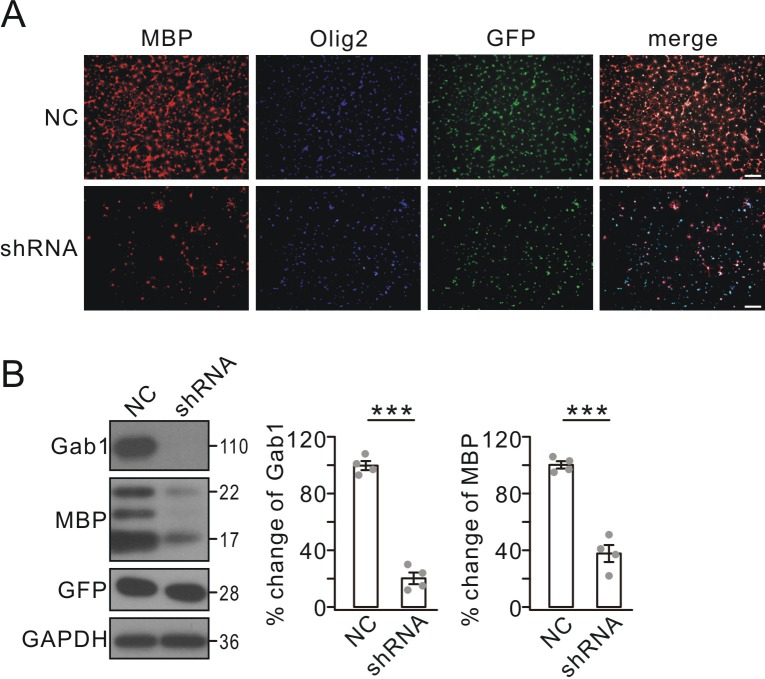
Effects of Gab1 knockdown on OPC differentiation in vitro.(A) OPC cultures were transfected with lentiviral vector-encoding with GFP (NC) or GFP-tagged Gab1 shRNA (shRNA), stimulated with T3 for 3 days, and immunostained with anti-MBP (red) and anti-Olig2 (blue) antibodies. Scale bar, 40 μm. (B) Expressions of Gab1, MBP, GFP, and GAPDH in OPCs treated with NC or shRNA following triiodothyronine treatment. Gab1 and MBP were normalized to corresponding GAPDH and percent changes are summarized. Gab1: 100 ± 4% (NC) and 20 ± 5% (shRNA) (p=0.00005). MBP: 100 ± 3% (NC) and 37 ± 7% (shRNA) (p=0.000075). n = 4/group. t-test, df = t(7). Gray dots indicate individual data points. ***p<0.001.